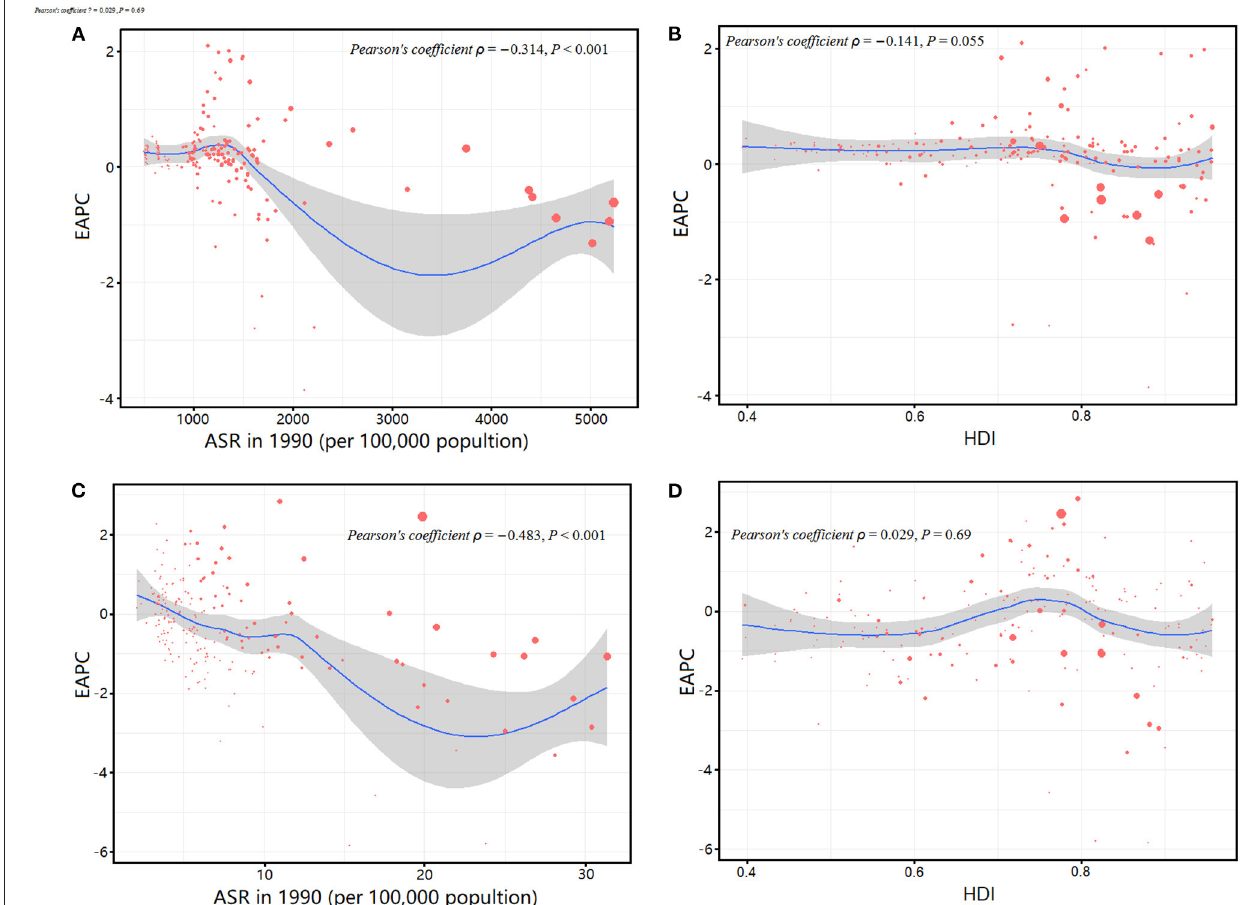
FIGURE 6 | Correlation between the EAPC of age-standardized incidence rates and the age-standardized prevalence rates in 1990 (A) ; the EAPC of age-standardized incidence rates and the HDIs in 2019 (B) ; the EAPC of age-standardized DALY rates and the age-standardized DALY rates in 1990 (C) ; and the EAPC of age-standardized DALY rates and the HDIs in 2019 (D) . The size of circle represents the age-standardized rates of incidence or DALYs in this country or territory in 2019. DALYs, disability-adjusted life years; EAPC, estimated annual percentage change; HDI, human development